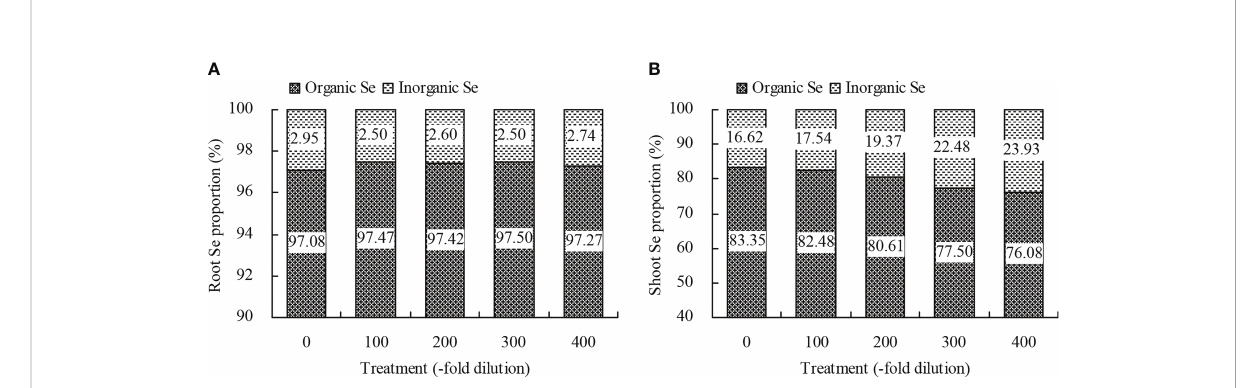
FIGURE 5 Proportions of organic Se and inorganic Se of peach seedlings. (A) : root Se proportion; (B) : shoot Se